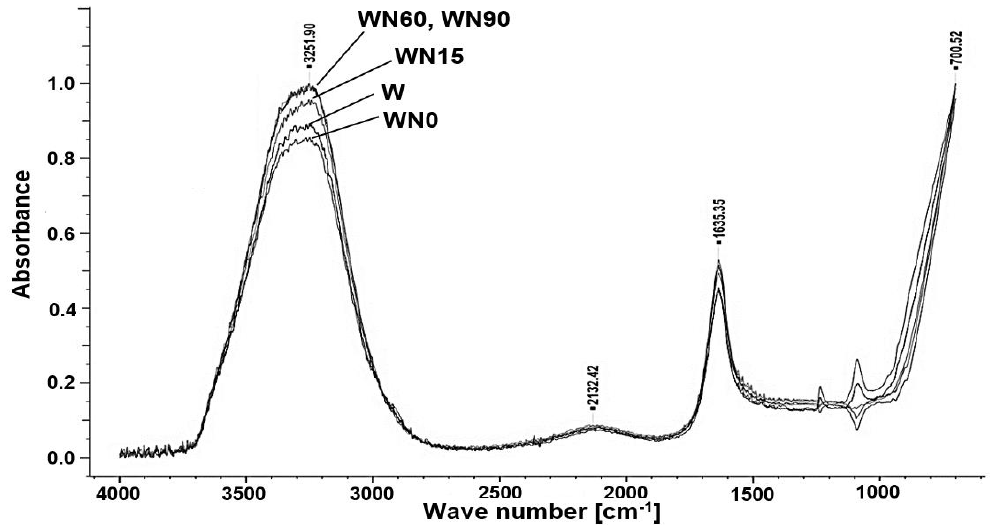
Figure 3. Fourier Transformation Infrared (FTIR) spectra of deionized water stored in contact with the air (W) and saturated with nitrogen prior (WN0) and after treating with GP for 5 to 90 min (WN5-WN90), respectively. Table 2. Intensity of the OH stretching (bands A and B a ) and bending (band C) modes in the FTIR spectra of water taken in the region of 4000 – 1500 cm − 1.